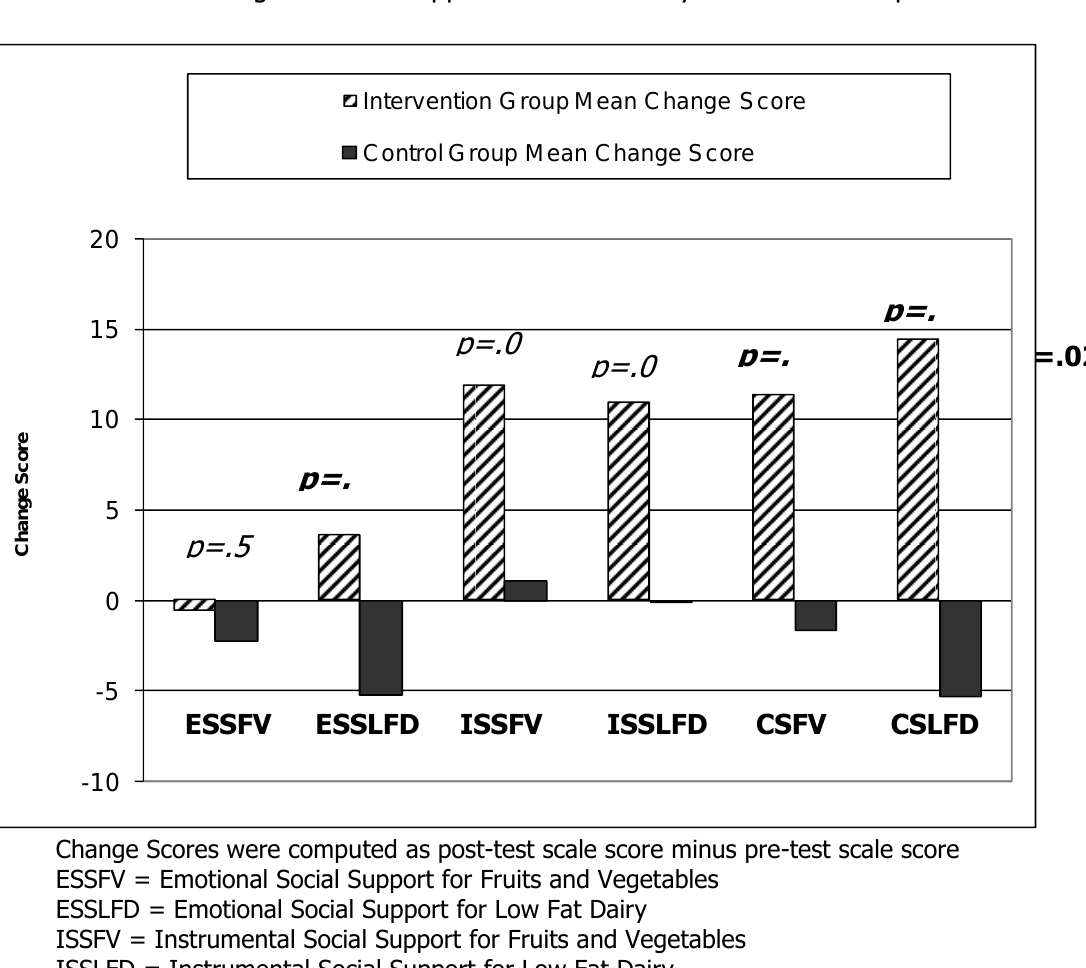
Change in Social Support Scale Scores by Treatment